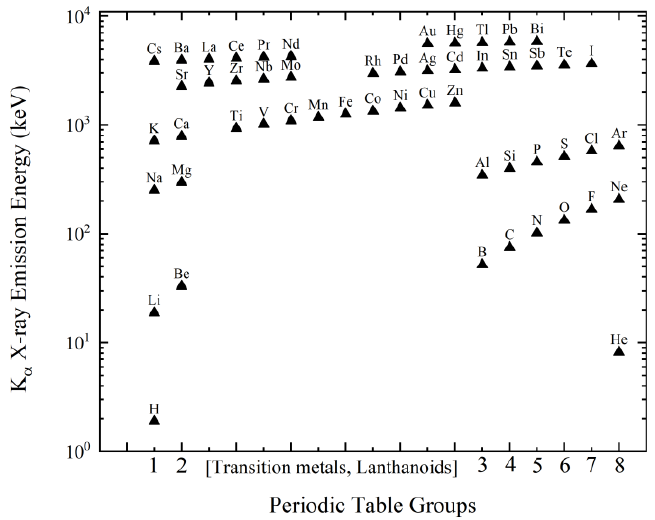
Figure 2. K-alpha energy values for the elements of the periodic table. Values are listed in [8,12]. Data was taken and adapted with permission from Ref. [7] © 2016, Elsevier Ltd.